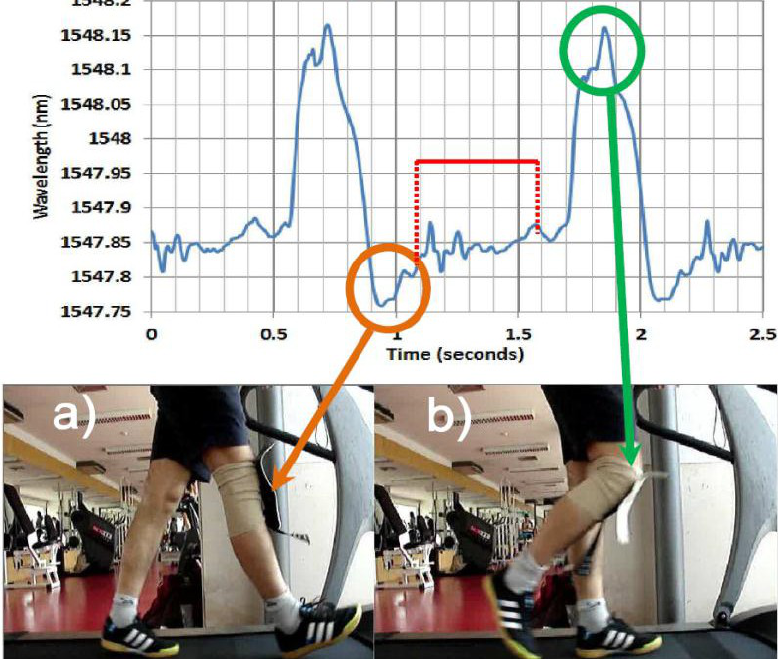
Figure 14. The wavelength values for a walking at 4 km/h. ( a ) and ( b ) show the minimum and maximum deflections of the FBG, respectively